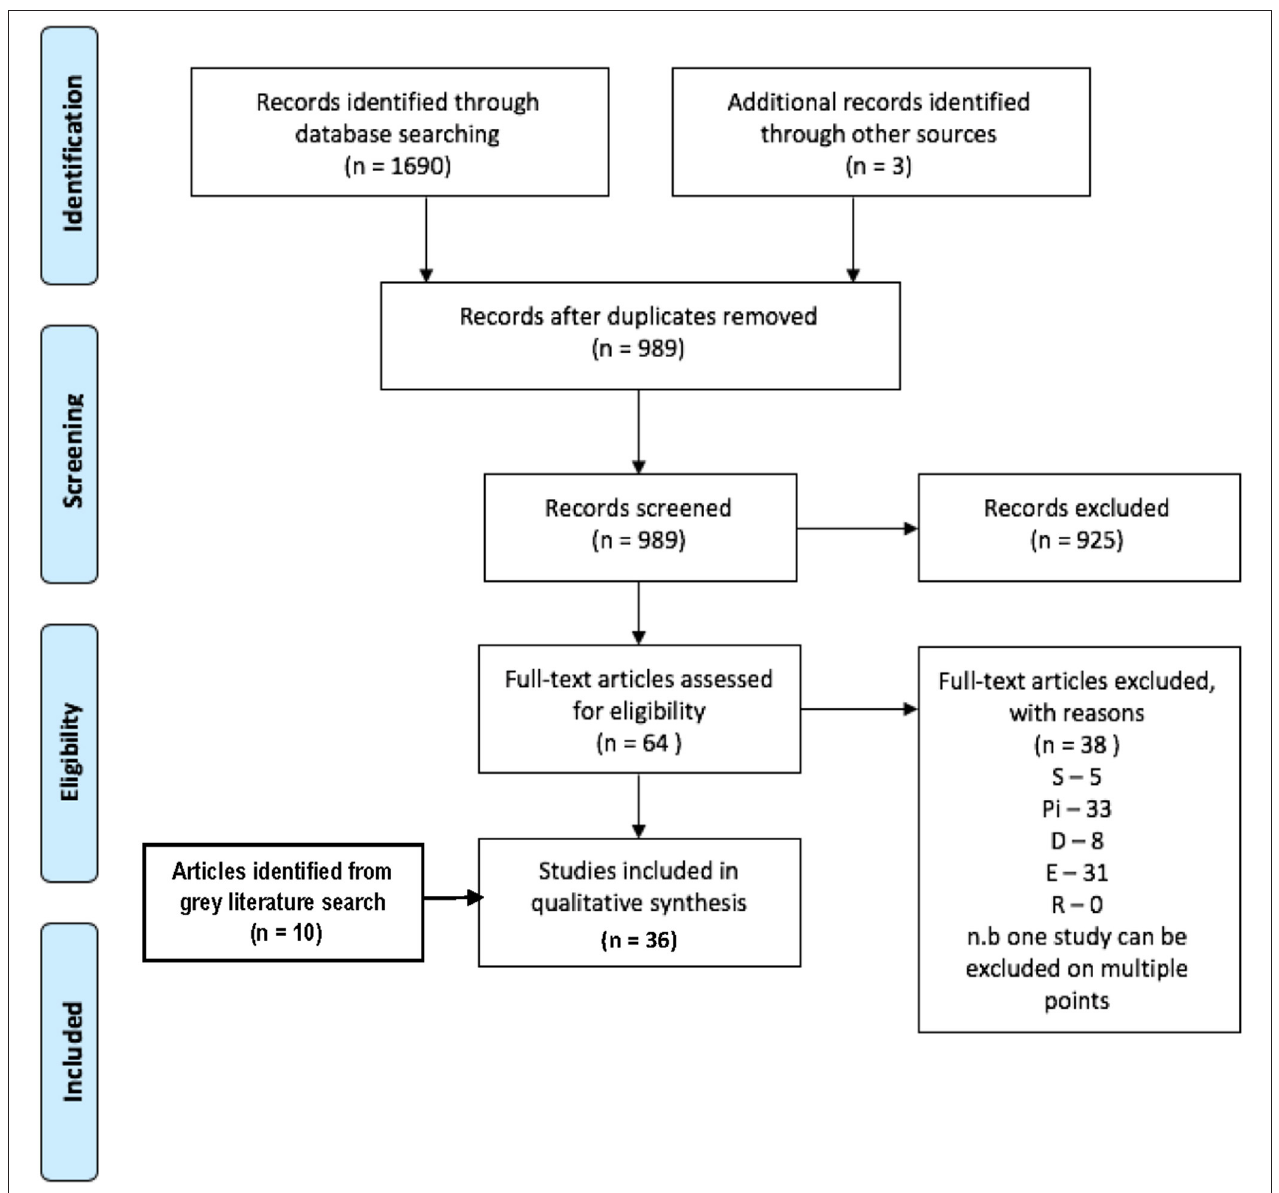
FIGURE 1 | Prisma flow chart for inclusion of articles for Search